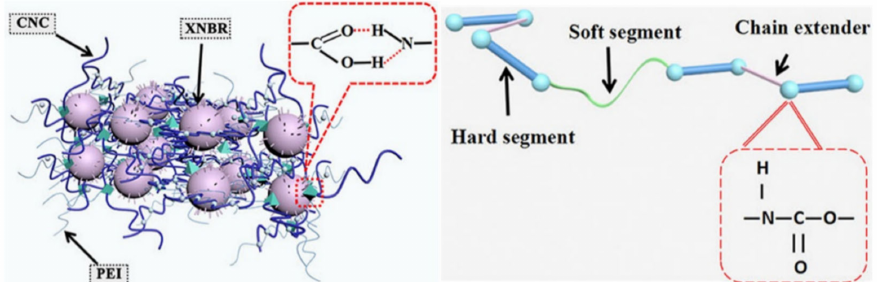
Figure 7. Self-healing mechanisms of composites and PU, respectively, where CNC, XNBR and PEI are cellulose nanocrystals, carboxylated nitrile rubber and polyethylenimine, respectively. Reprinted with permission from [123]. Copyright (2020) American Chemical Society.